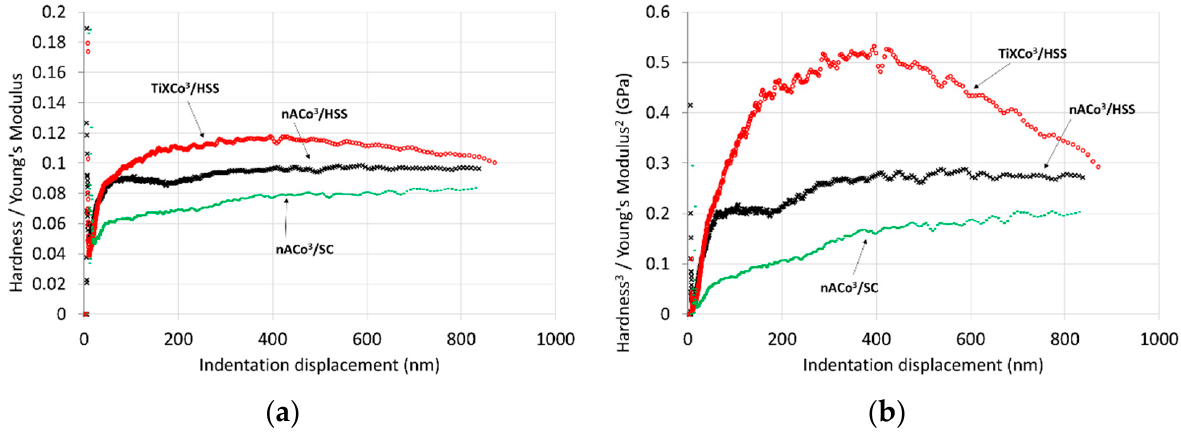
Figure 7. Calculated mechanical properties of experimental samples: ( a ) Plasticity index H/E , ( b ) plastic deformation resistance H 3 / E 2 .